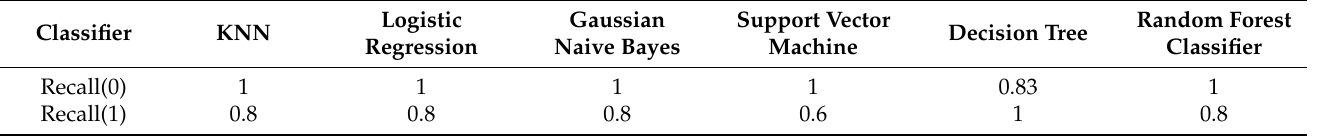
Table 15. Recall based on validation